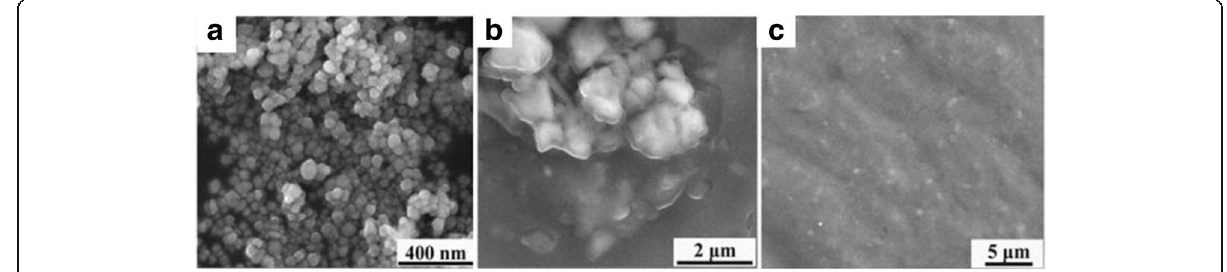
Fig. 2 SEM images of P(OEGDA-MAA) obtained from their dispersion at room temperature at different concentration in water at 1 mg/mL ( a ) and in ethanol at 5 mg/mL ( b ) and 10 mg/mL ( c )